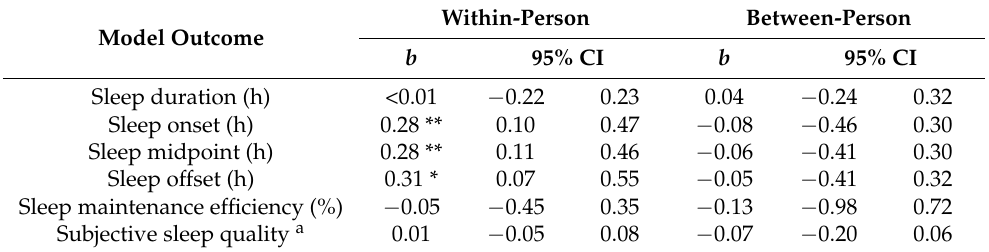
Table 3. Caffeinated beverage consumption predicting sleep within and between adolescents ( n =